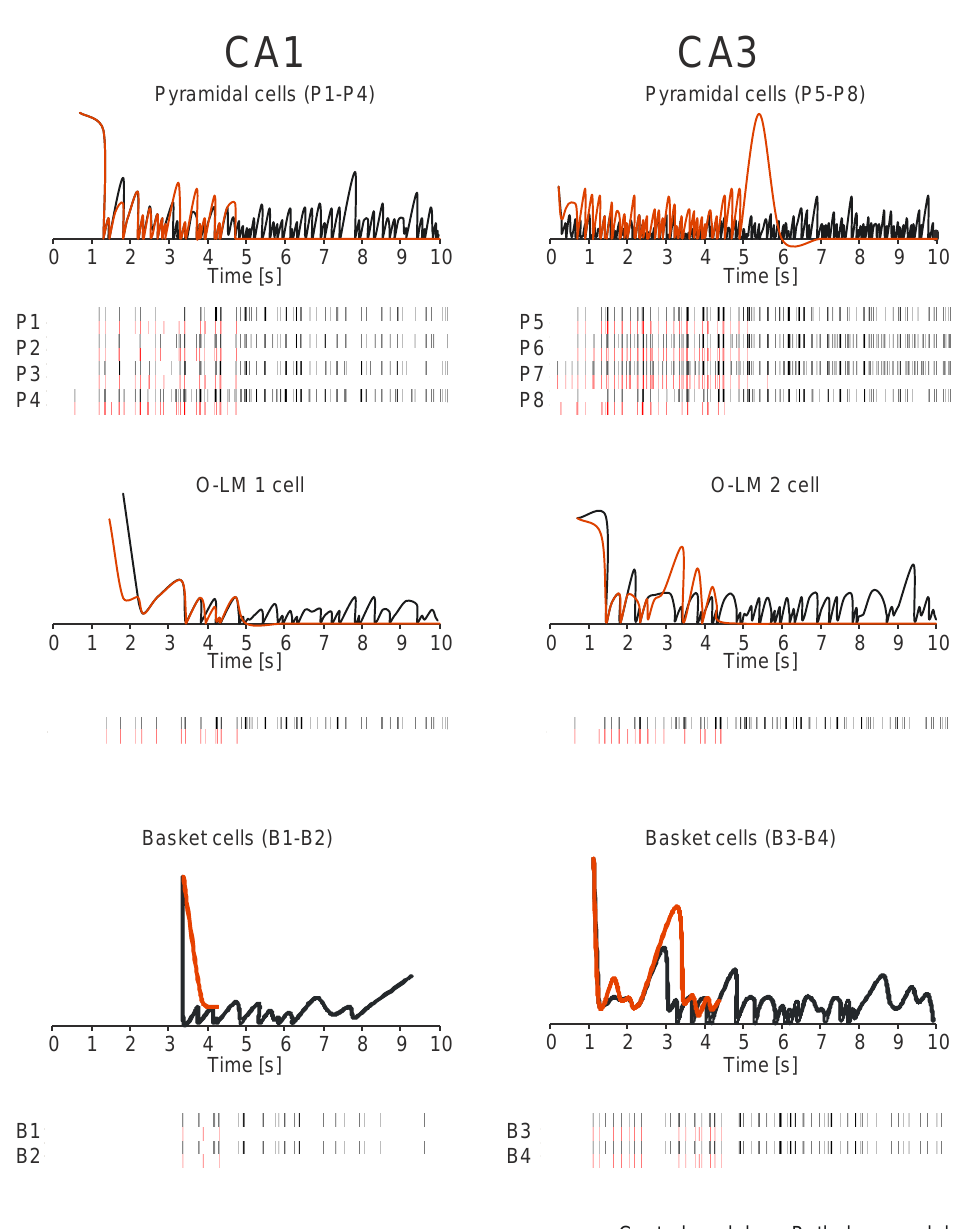
Figure 4. Ten second real-time simulation of CA3-CA1 network control model and pathology model. The time course of Interspike Intervals (ISI) and output spikes trains for main cells of CA3-CA1 formations (top-pyramidal cells (P1-P8), medium-OL-M cell (1 and 2) and bottom basket cells (B1-B4)).